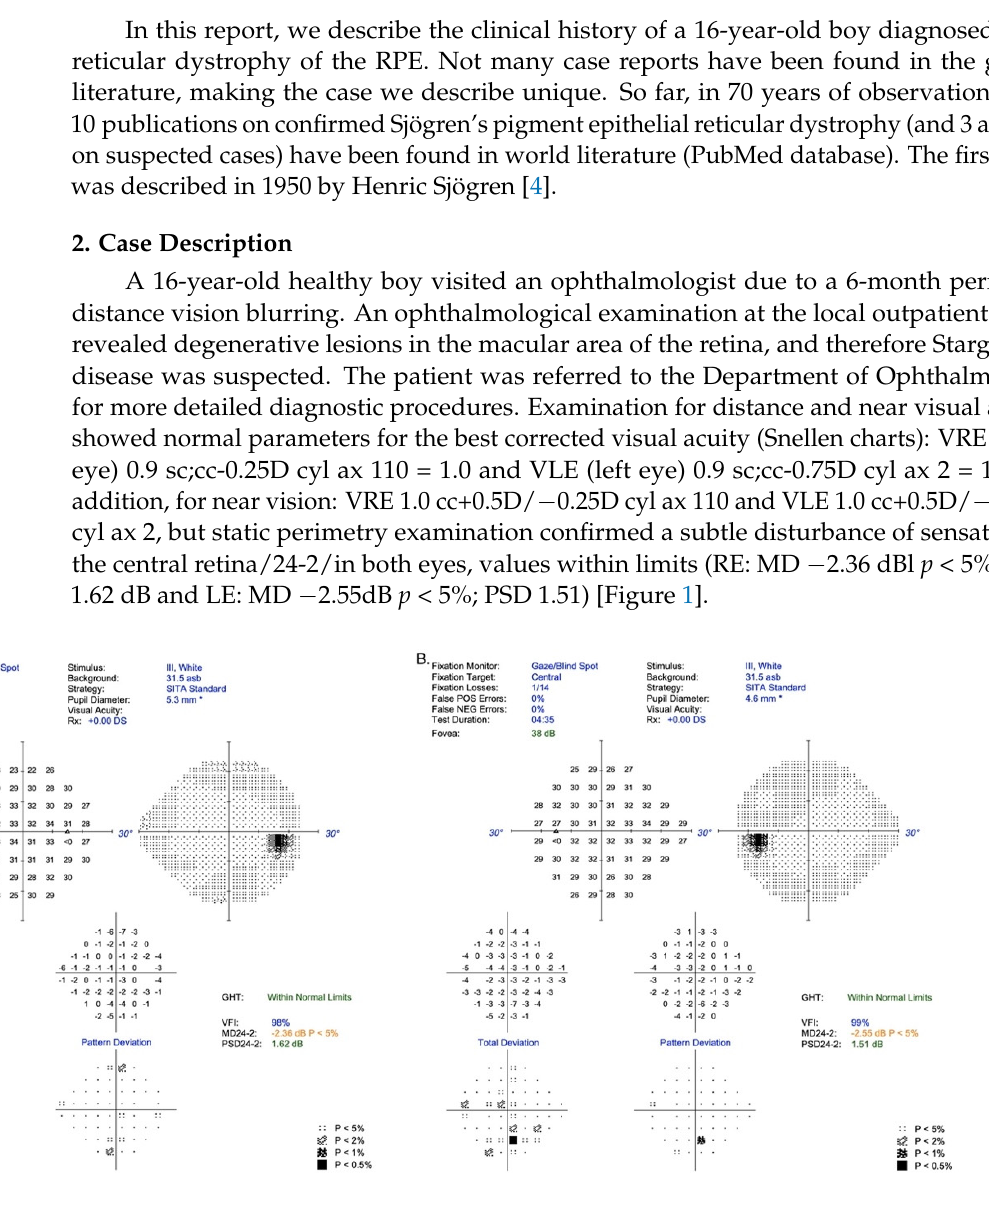
Figure 1. Static perimetry, ( A ) Right eye; ( B ) Left eye.